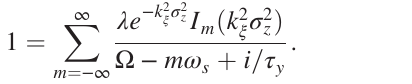
FIG. 4. Ratio of the theoretical growth rate including → ∞ as a function of longitudinal damping to that with τ z the dimensionless growth rate at zero chromaticity ℑ ð ω 1 = 500 , while the dashed lines Solid lines assume τ z s ¼ ω 1 = 100 have τ z s ¼